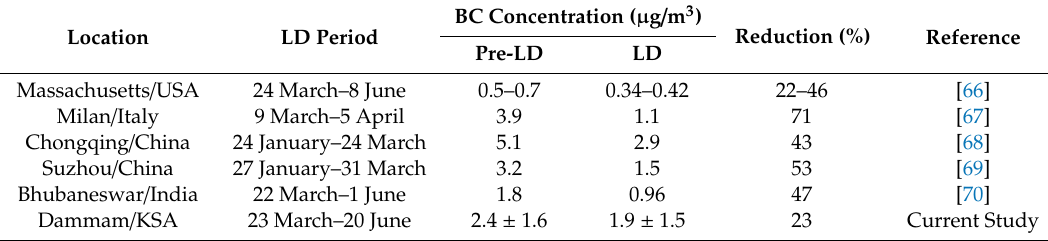
Table 4. BC levels and changes in di ff erent regions before and during COVID-19 lockdowns. Location LD